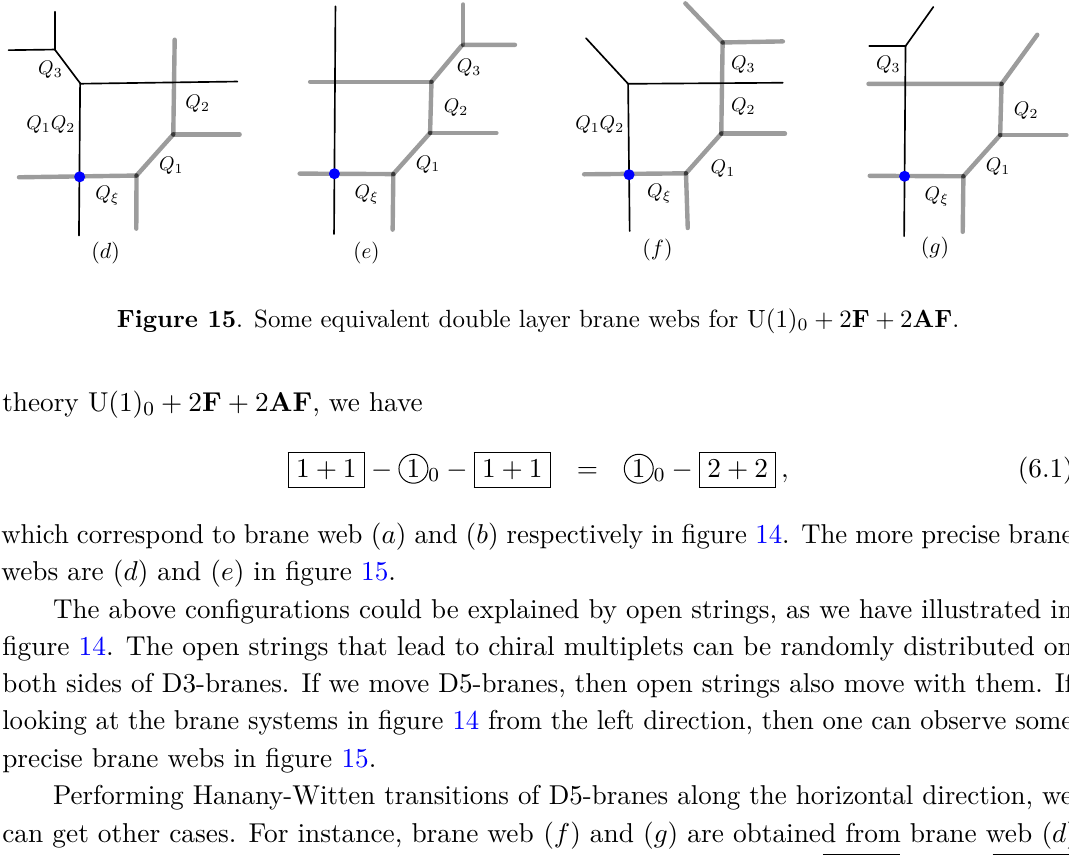
Figure 14 . It is free to move flavor D5-branes (dark nodes). In brane web ( a ) , we move two D5-branes to opposite directions and attach them to NS5-brane and NS5’-brane separately. In brane web ( b ) , we move both flavor D5-branes to the NS5’-brane. The blue wave lines denote D3-D5 strings that give rise to chiral multiplets.